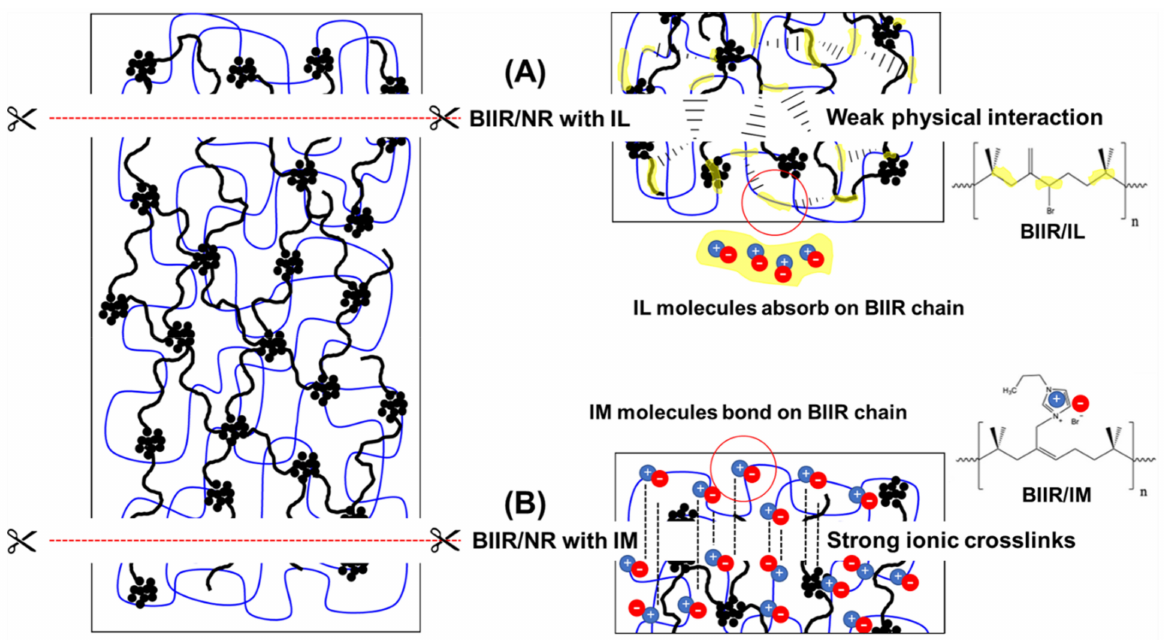
Figure 10. Proposed model of the BIIR/NR-CNT CB composites filled with IL ( A ) and IM ( B ).